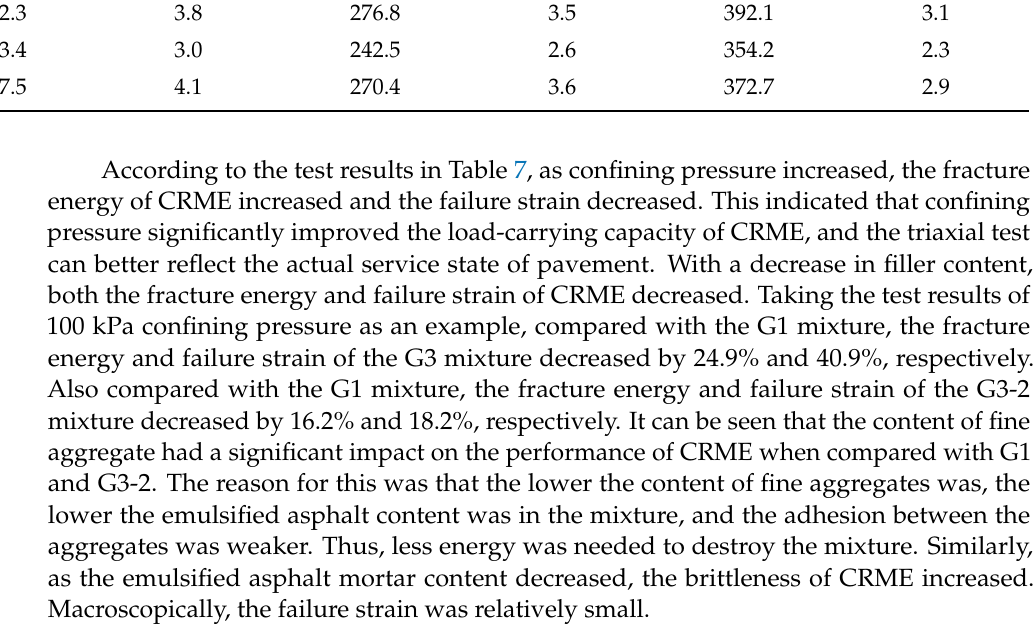
Figure 5. Triaxial test results for the mixtures with different fine aggregate gradations.